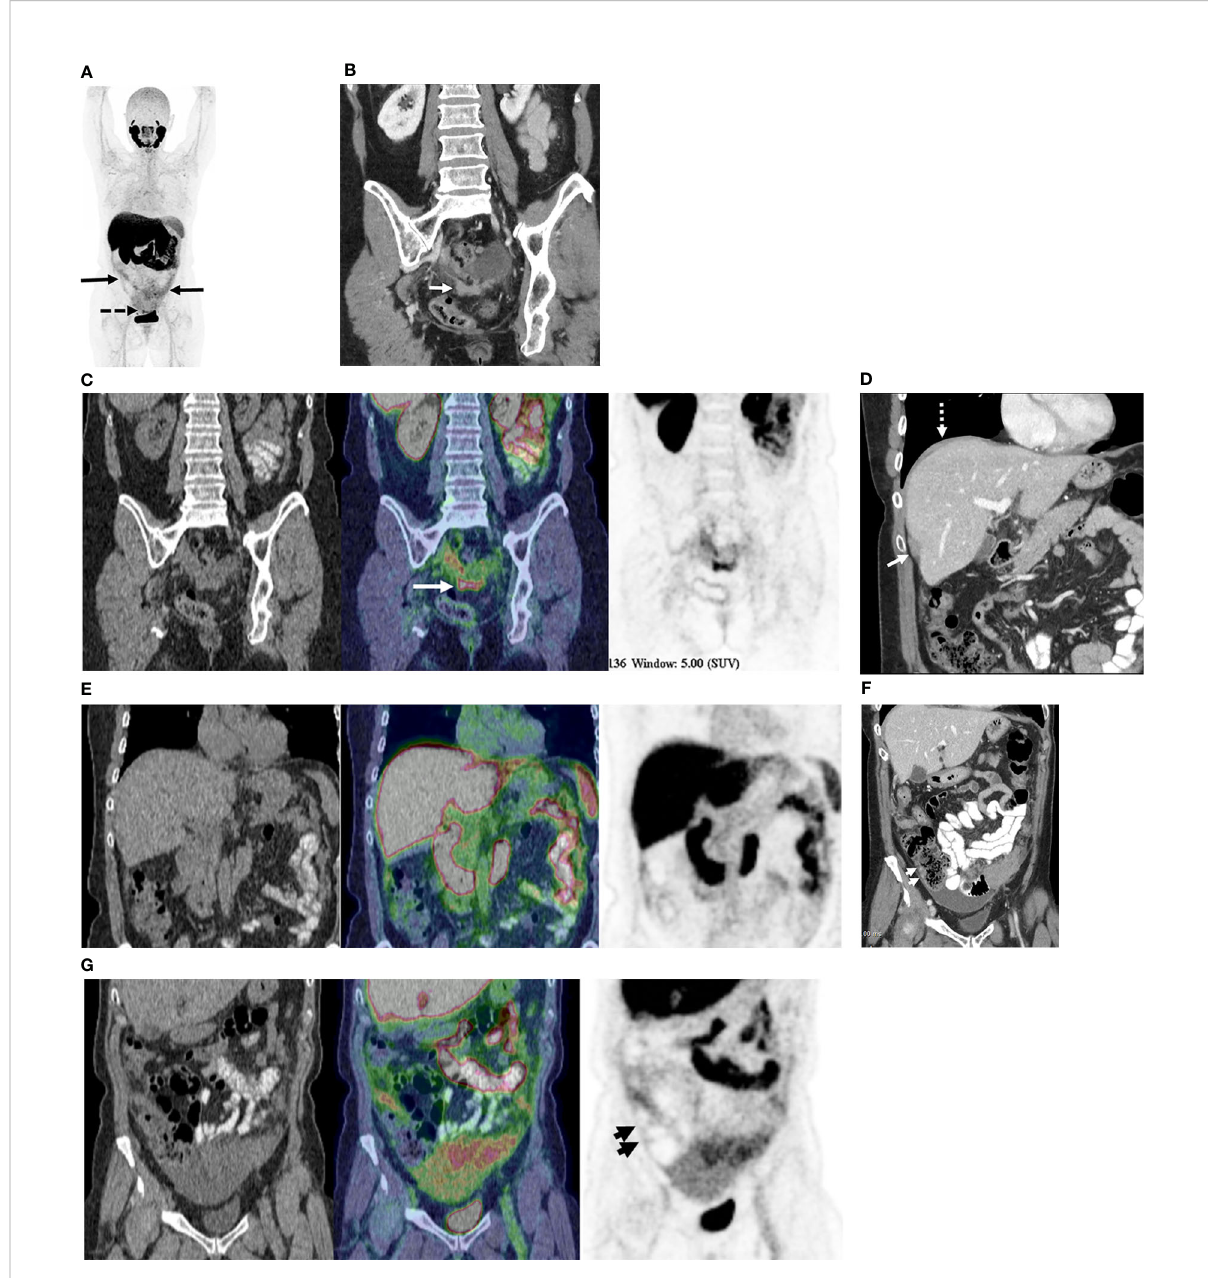
FIGURE 3 68-year old with stage IIIC high-grade serous ovarian cancer. (A) Maximum Intensity Projection image of 18F-DCFPyL shows mild to moderate radiotracer uptake in omental metastases (solid arrows) and moderate radiotracer uptake in pelvic peritoneal metastases (dotted arrows). (B) Coronal contrast enhanced CT image shows peritoneal deposits in the posterior cul-de-sac (arrow). (C) Coronal PET/CT image (CT - left, fused PET/CT image – middle; PET – right) corresponding to B shows moderately radiotracer uptake in same metastatic deposit (concordant CT and PET). Metastatic disease was con fi rmed at surgery. (D) Coronal contrast enhanced CT image shows metastatic disease on right diaphragm (dotted arrow) and along capsular surface of liver (solid arrow). (E) Coronal PET/CT image (CT - left, fused PET/CT image – middle; PET – right) corresponding to D show no focal radiotracer uptake visible on right diaphragm or liver capsule. Surgical pathology con fi rmed CT fi ndings of metastatic disease at these sites. (F) Coronal contrast enhanced CT image shows focal thickening along right lateral wall of ascending colon (short arrows), suspected to represented serosal metastasis. (G) Coronal PET/CT image (CT - left, fused PET/CT image – middle; PET – right) corresponding to F shows no focal radiotracer uptake on the serosal surface of the ascending colon. No serosal disease on surface of the right colon was found at